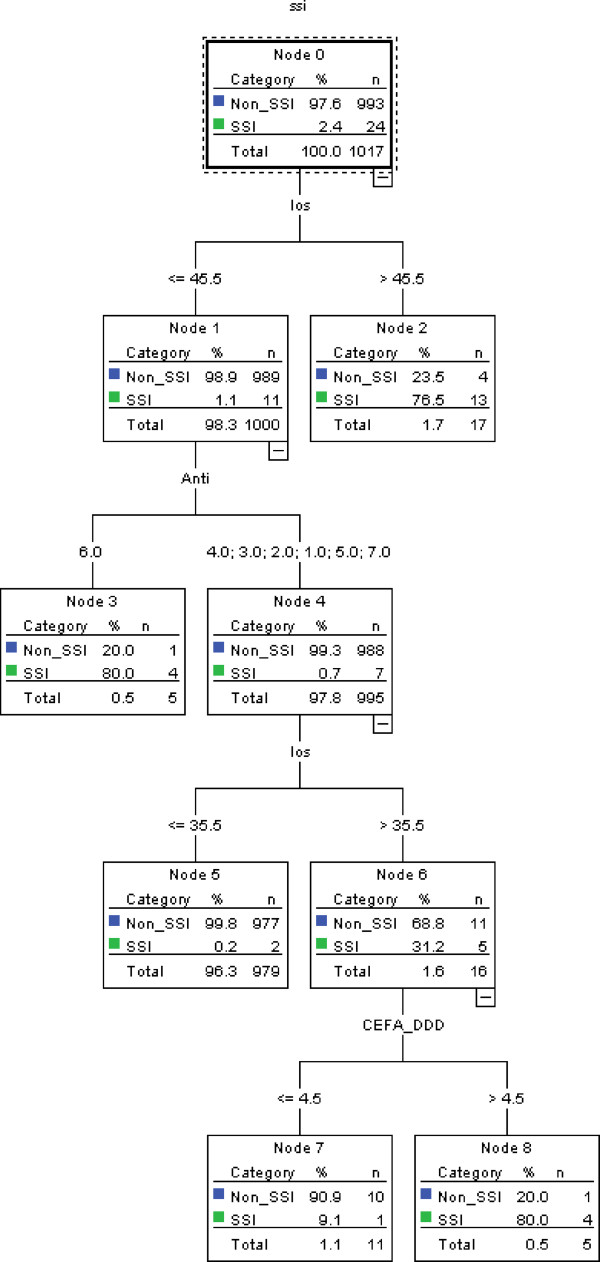
Decision tree model for identifying cases of CABG surgical site infection (after pruning). SSI: surgical site infection; los: length of stay; Anti: type of antibiotics; CEFA_DDD:dosage of cefazolin.